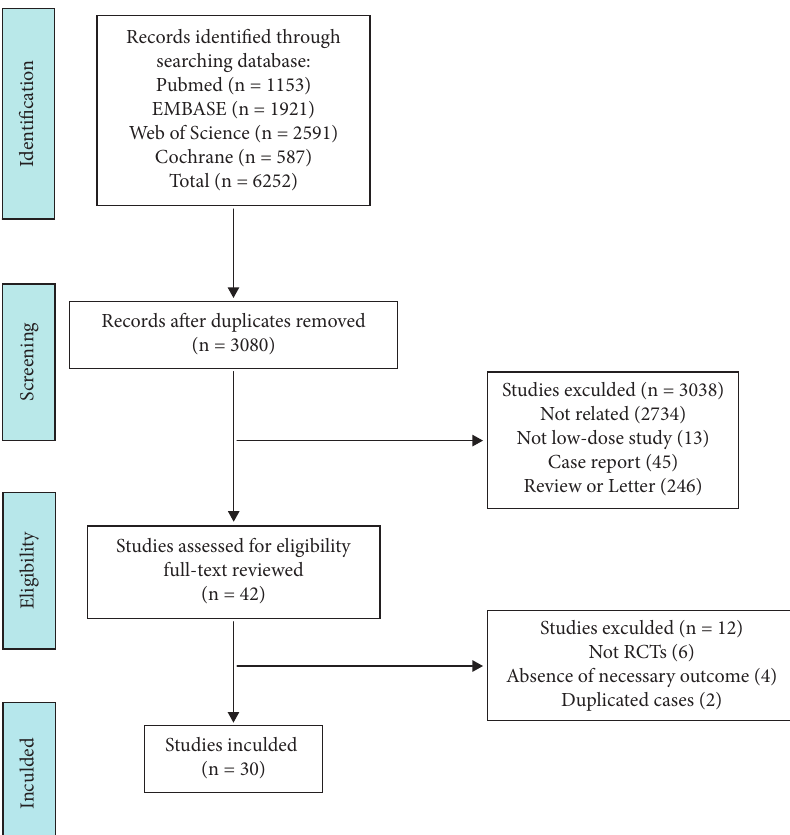
Figure 1: Flow diagram depicting the literature review, search strategy, and selection